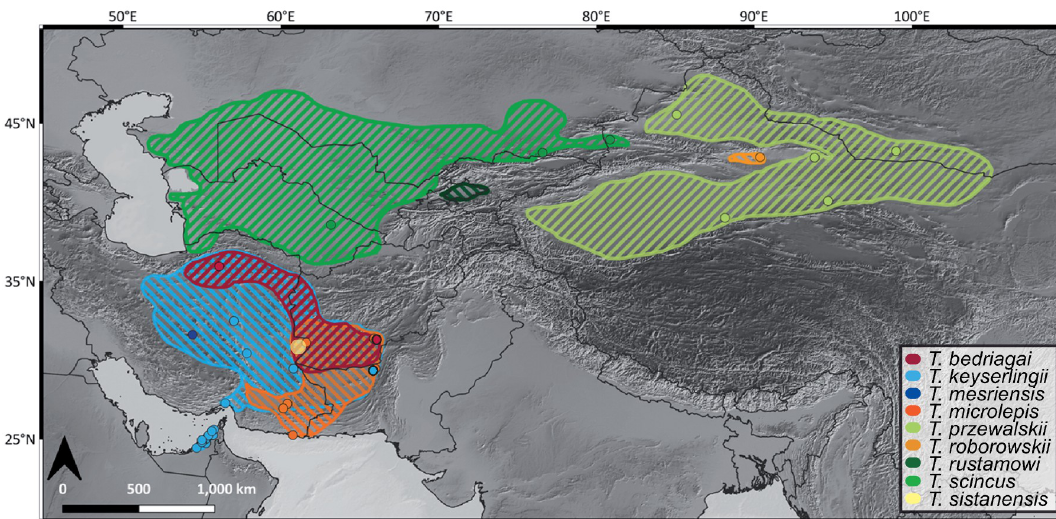
Fig 1. Distribution ranges of Teratoscincus taxa. Colours correspond to species in Figs 3 and 4. Localities of specimens sampled in this study are detailed in S1 Table. Teratoscincus sistanensis was not included in this study. Credits: Natural Earth contributors, SRTM.